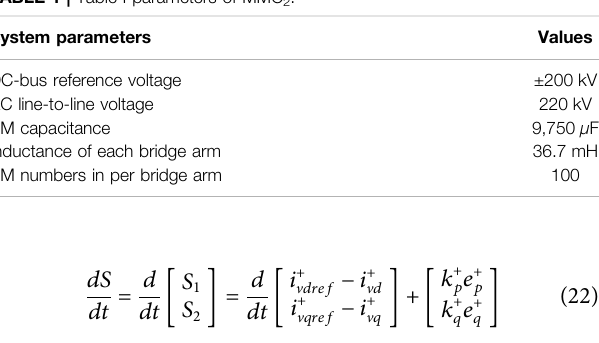
TABLE 1 | Table I parameters of MMC 2